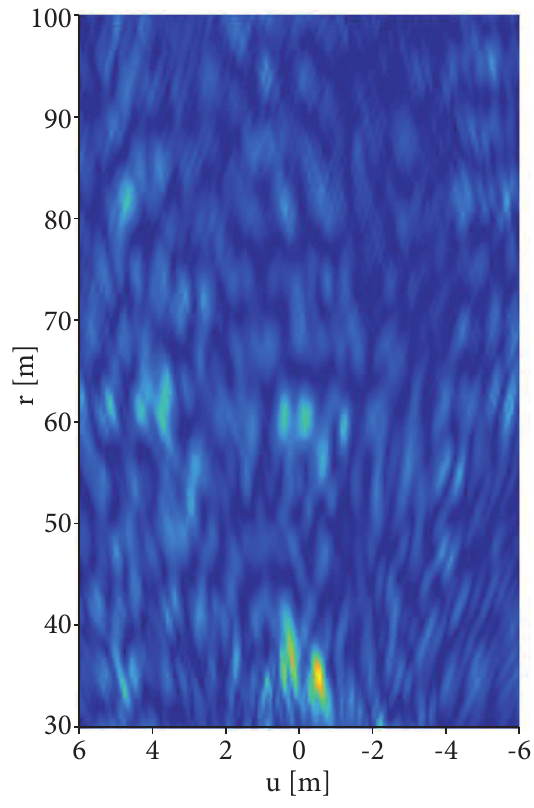
Figure 15. Focused image from raw data using the RMA-MIT in the range from 30 to 100 meters.